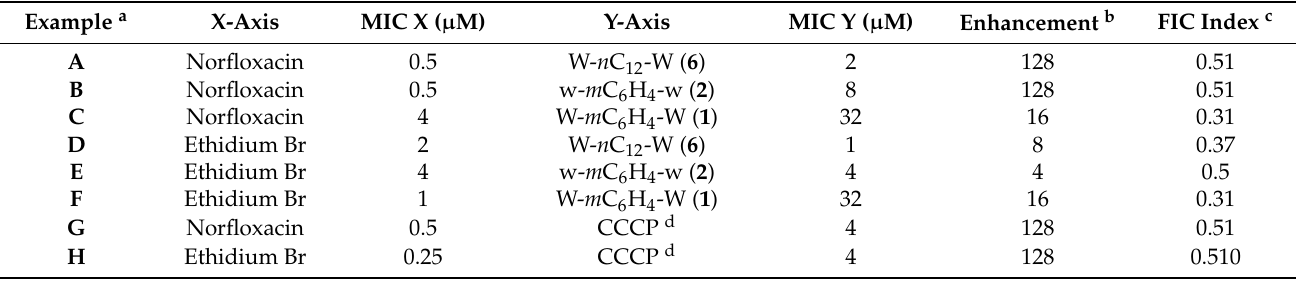
Figure 6. Fluorescence-based assay for propidium iodide penetration of S. aureus cells. RFU = relative fluorescence units. TX100 = Triton X-100. W = L-tryptophan; w = D-tryptophan. Each bar represents three independent determinations; error bars removed for clarity. The compound numbers corresponding to the structures are W- m Ph-W, 1 ; w- m Ph-w, 2 ; and W-C 12 -W, 6 . Table 3. Quantitative summary of Figure 7 S. aureus